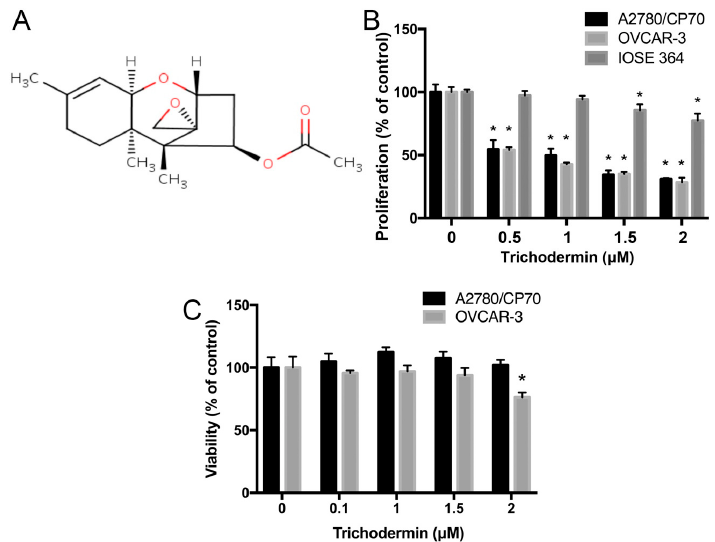
Figure 1. Trichodermin preferentially decreased the proliferation of human ovarian cancer cells. ( A ) Chemical structure of trichodermin. ( B ) The impacts of trichodermin on the proliferation of two human ovarian cancer cell lines (A2780/CP70 and OVCAR-3 cells) and one normal human ovarian surface epithelial cell line (IOSE-364 cells) after 24 h treatment. ( C ) The impacts of trichodermin on the viability of A2780/CP70 and OVCAR-3 cells after 24 h treatment. * p < 0.05 compared with the control